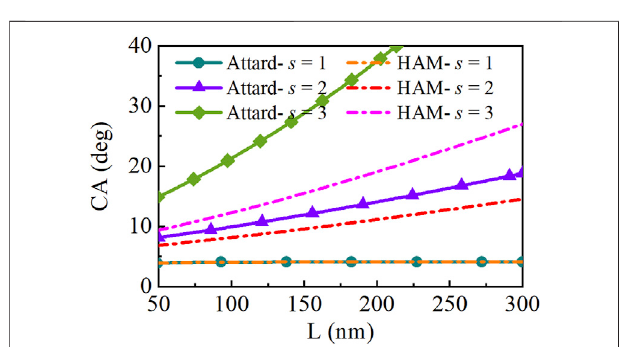
FIGURE 5 | The relation between contact rim radius L and equilibrium contact angle (CA) with different saturation ratios in the two models: state- dependent surface tension model and hydrophobic attraction model